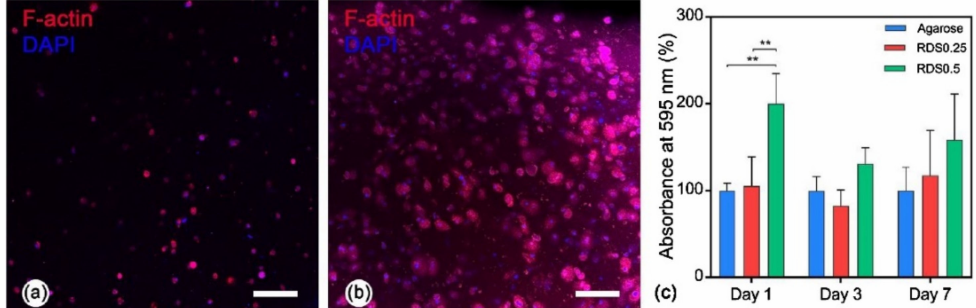
Figure 16. ( a ) Growth and cytoskeleton of fibroblasts cultured for a week in AGA gel; ( b ) growth and cytoskeleton of fibroblasts cultured for a week in AGA/LAP BI containing 0.25% ( w / v ) of clay mineral; ( c ) Metabolic activity of fibroblasts cultured within three different BI: pure AGA, AGA/LAP with 0.25% and 0.5% ( w / v ) of LAP (mean ± SD, ** p < 0.01, n = 3). Reproduced with permission from [112], Elsevier,